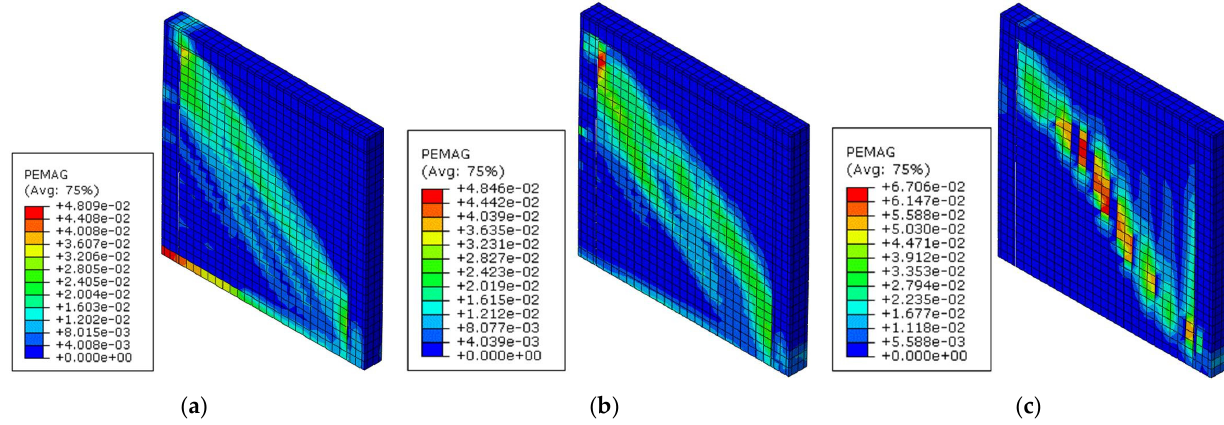
Figure 29. Plastic strain magnitude of the walls with different vertical compressive stress: ( a ) wall ZWZ-10; ( b ) wall ZWZ-11; ( c ) wall